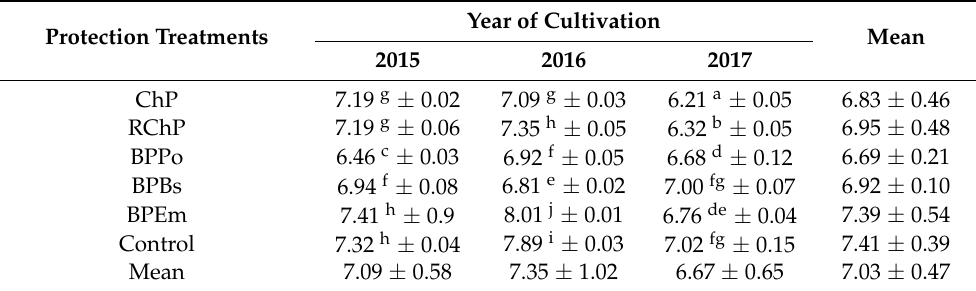
Table 11. Effect of protection treatments and the year of horseradish cultivation on ash content (g · 100 g − 1 dry